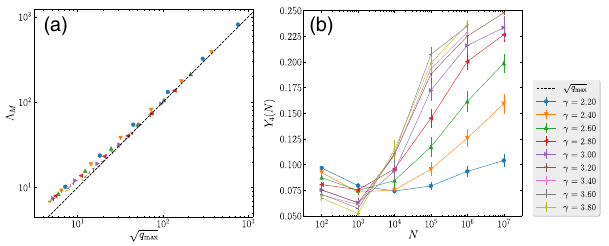
FIG. 4. (a) Largest eigenvalue Λ rewired LPA networks with different degree exponent γ . (b) In- verse participation ratio Y 4 ð N Þ as a function of N in rewired LPA networks with different degree exponent γ . Each point in both graphs corresponds to an average over 100 independent network realizations. Error bars are smaller than symbol sizes.